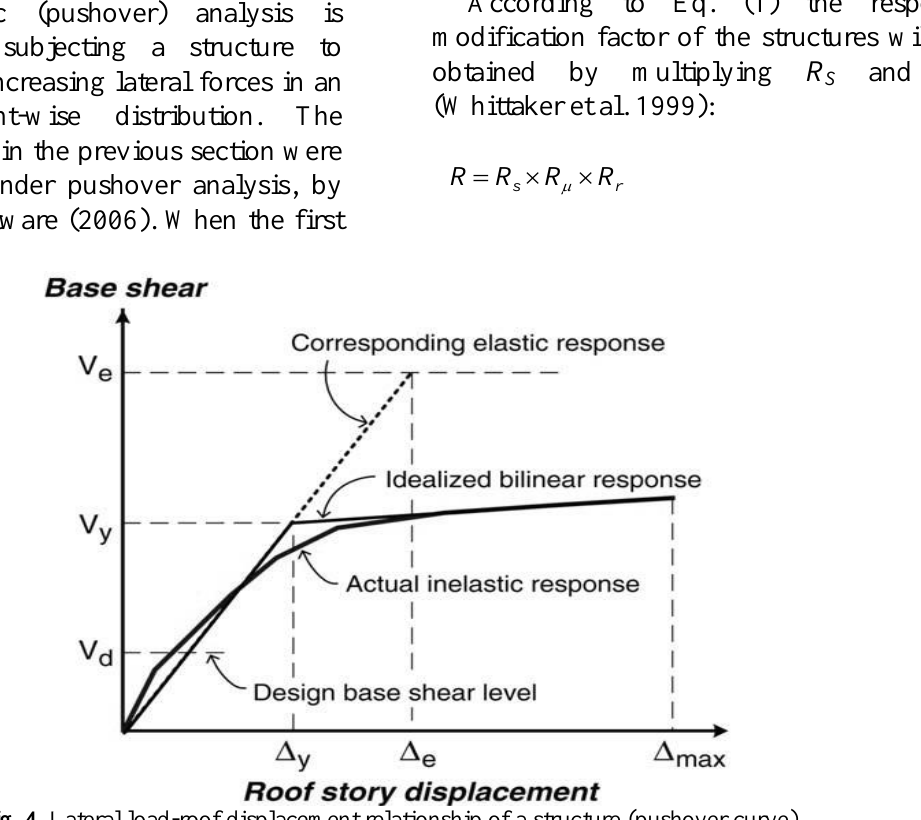
Fig. 4. Lateral load-roof displacement relationship of a structure (pushover